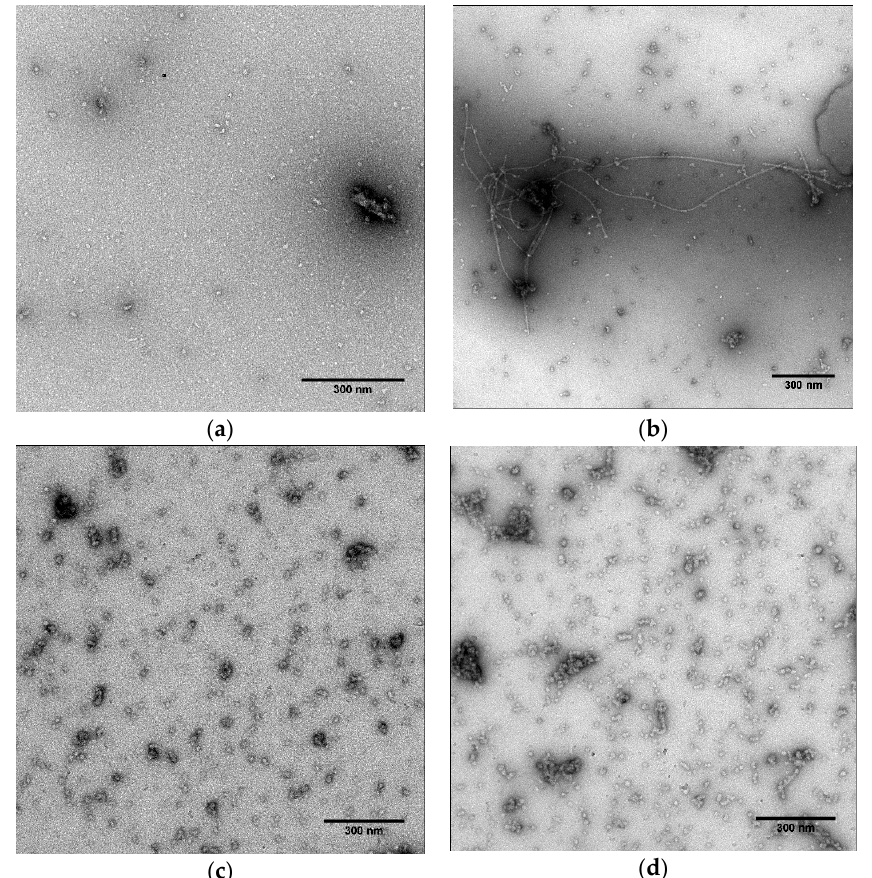
Figure 3. Direct transmission electron microscopy (TEM) observation of α -synuclein aggregation states: ( a ) α -synuclein (70 µ M in a 20 mM Na 2 HPO 4 /NaH 2 PO 4 140 mM Tris buffer, pH 7.4) before aggregation; ( b ) aggregated alone for 4 days at 37 °C; or ( c ) with 100 μ M of piceatannol. To observe fibril destabilization; ( d ) 100 µ M of piceatannol was added to α -synuclein fibrils and then observed after 15 min. Scale bar indicates 300 nm.